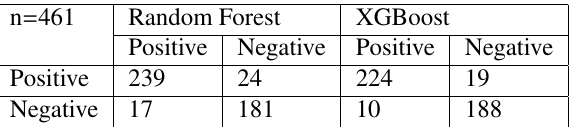
Table 3. Confusion Matrices values of Random Forest